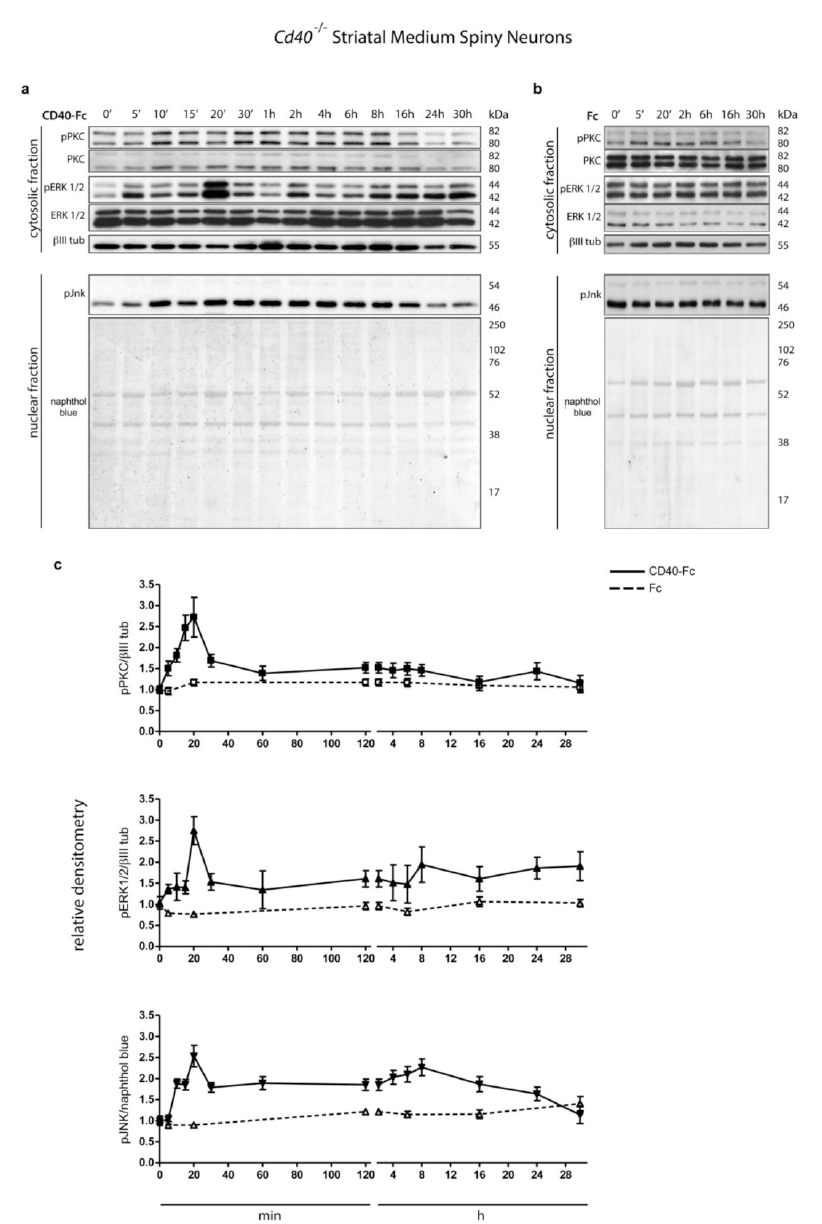
Figure 1. Protein kinase C (PKC), extracellular regulated kinases 1 and 2 (ERK1/2), and c-Jun N -terminal kinase (JNK) phosphorylation after stimulating CD40L reverse signalling. ( a , b )